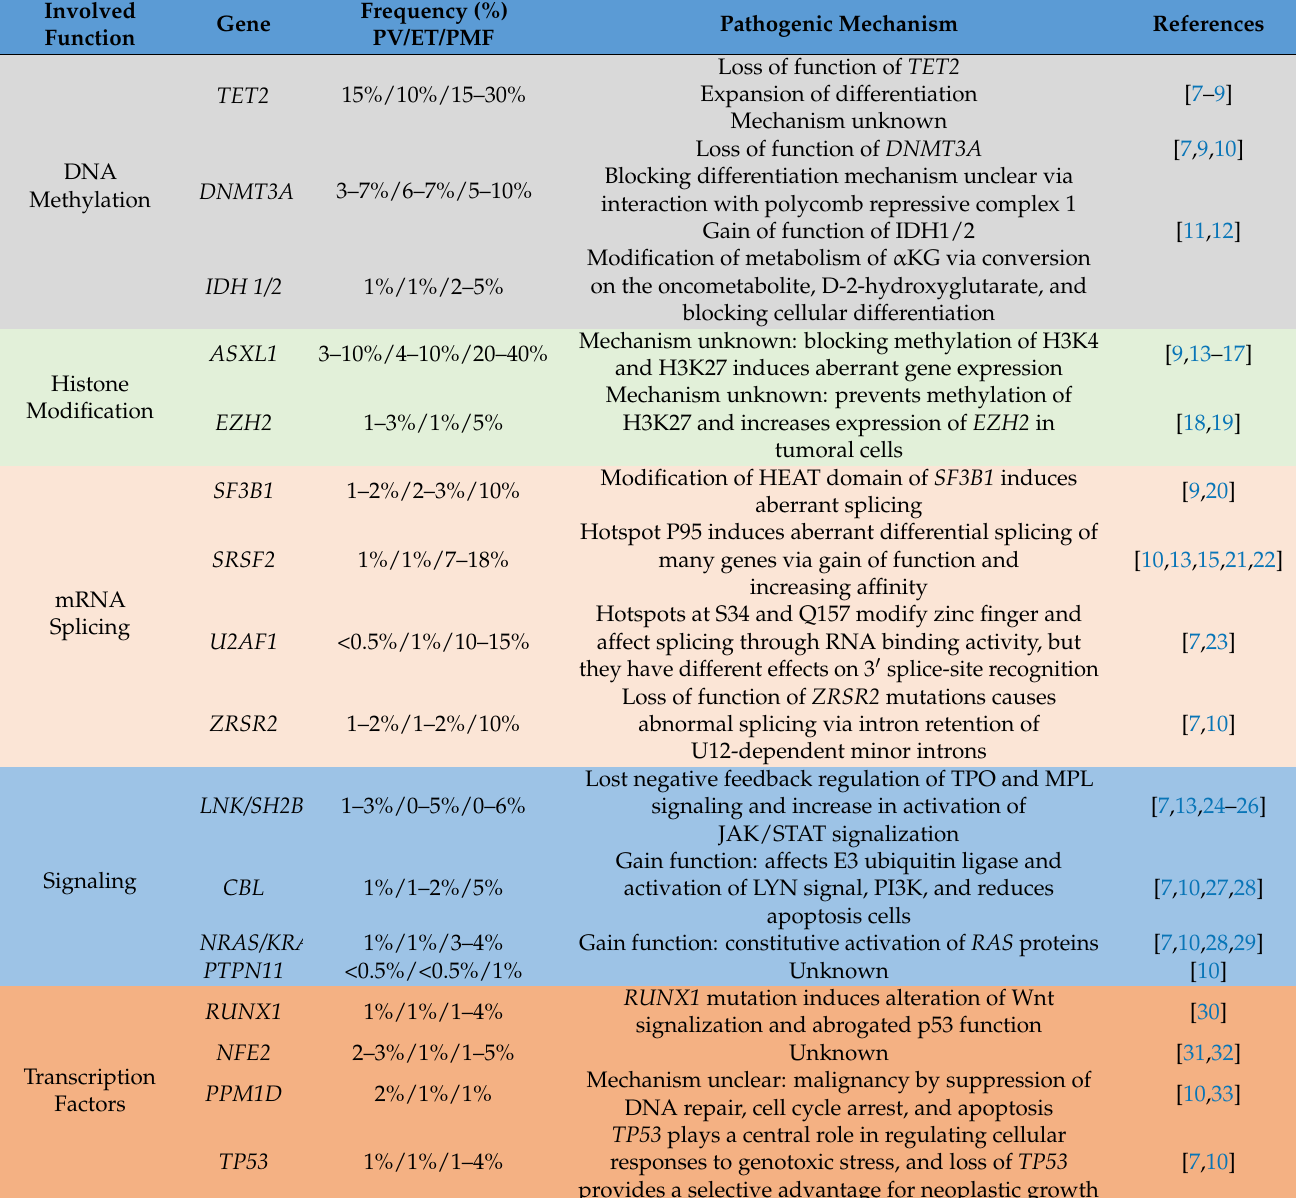
Table 1. Recurrent additional mutations in patients with